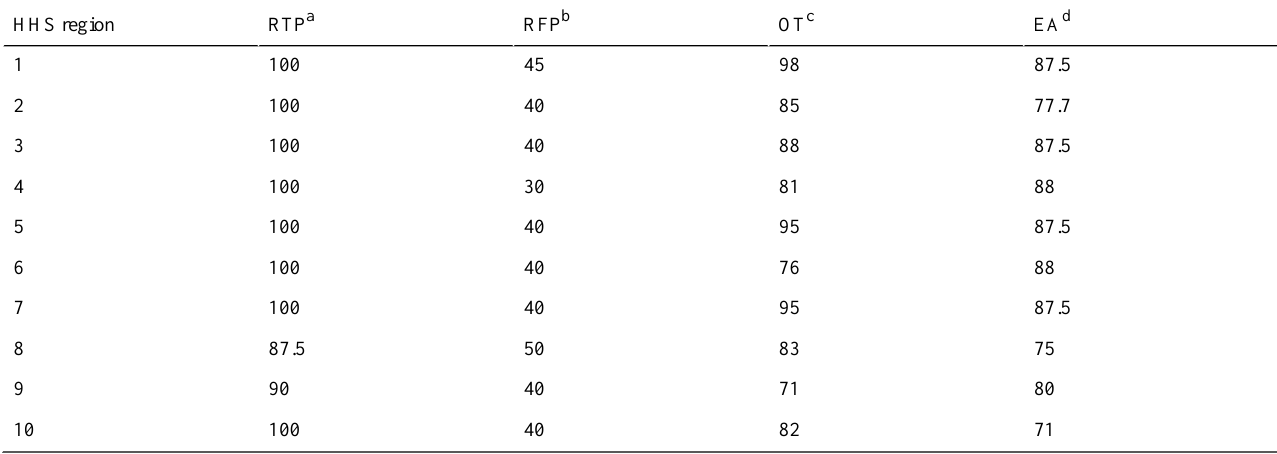
Table 3. Result of negative binomial cumulative sum (cut-off = 15), for all performance metrics across all Department of Health and Human Services (HHS) regions of the United States.